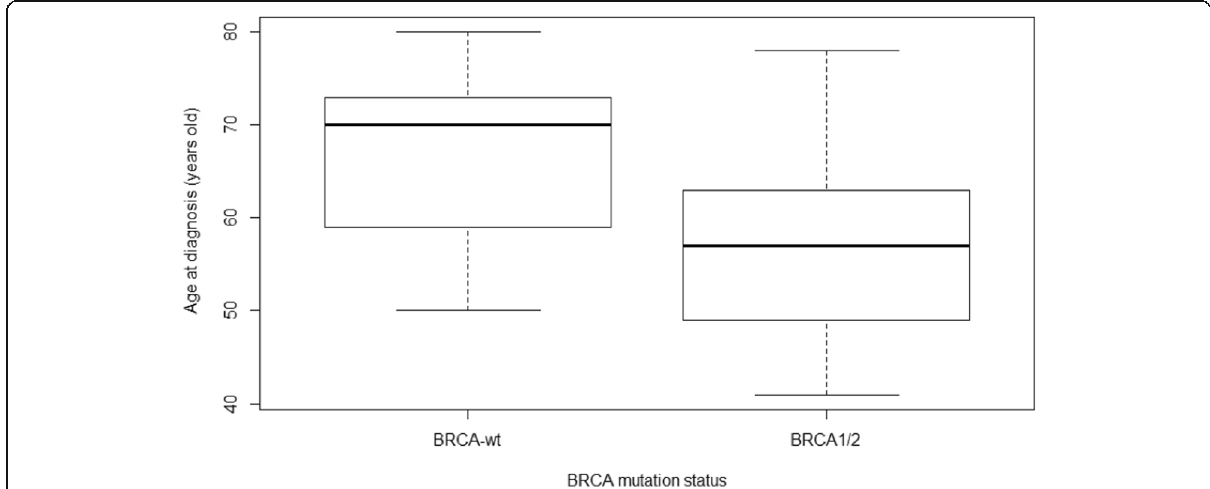
Fig. 4 Comparison between the age of the patients at diagnosis of BRCA -mutant HGSC and BRCA-wild